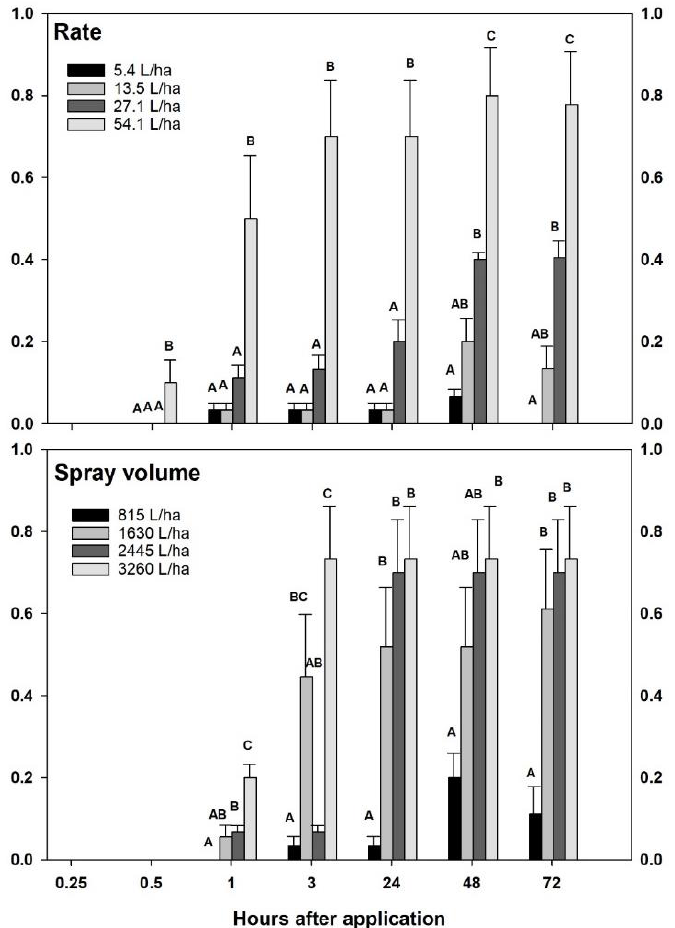
Figure 1. Cumulative effect of Civitas rate (top panel; at constant 815 L/ha carrier volume) and carrier volume (bottom panel; at constant 13.5 L/ha Civitas) on adult Listronotus maculicollis mortality between 0.25 to 72 h after application. Treatments within each interval were control corrected prior to analysis. Where polynomial contrasts detected significant relationships, one-way ANOVA was used to separate treatment means within time intervals at the at α = 0.05. Means marked with the same letter do not differ significantly from one another.